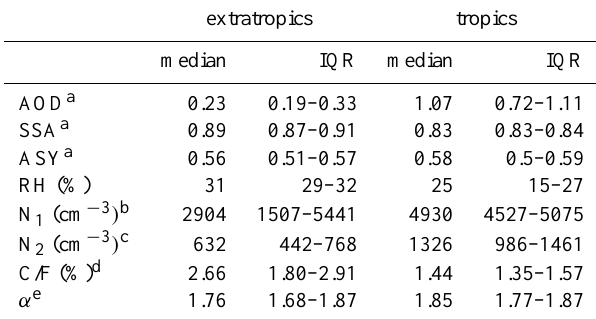
Table 1. Characteristic properties of the extratropical and tropical Southern Hemisphere African aerosol measured during SAFARI- 2000, which include the median values (and interquartile range, IQR) of aerosol optical depth (AOD), single scattering albedo (SSA), asymmetry parameter (ASY), relative humidity (RH), aerosol number concentration (N 1 , N 2 ) , coarse to fine particle vol- ume ratio (C/F), and aerosol angstrom exponent ( α)